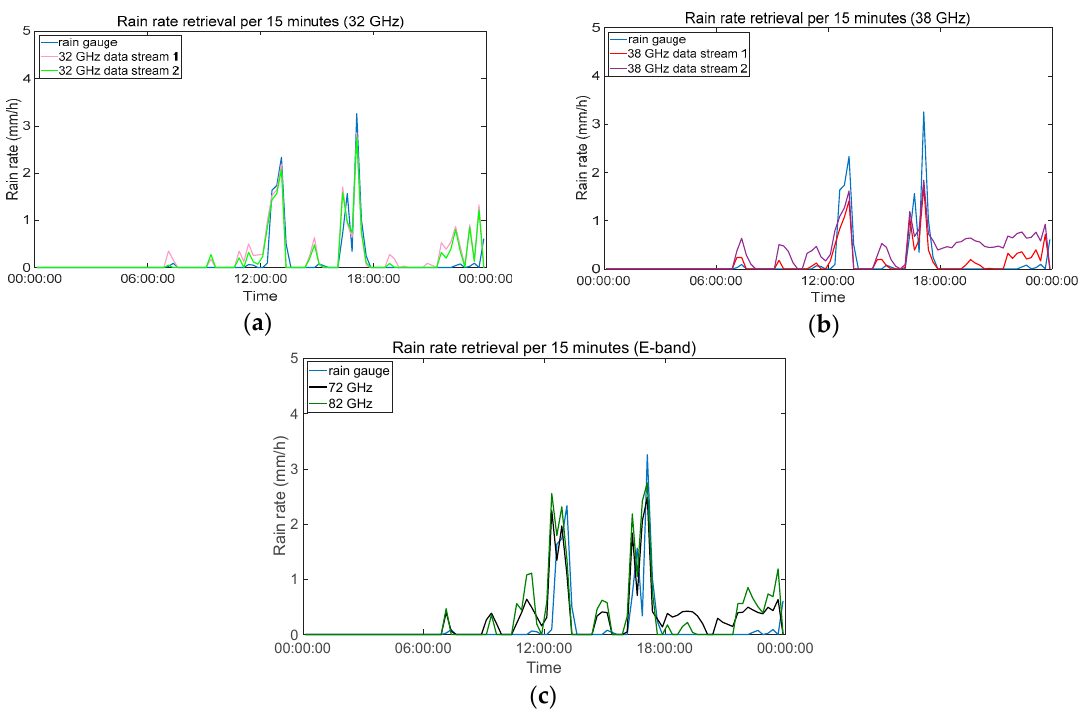
Figure 8. Average rain rate per 15 min derived from the signal link compared with the rain gauge measurement on 7 June 2017: ( a ) 32 GHz link; ( b ) 38 GHz link; ( c ) E-band link.